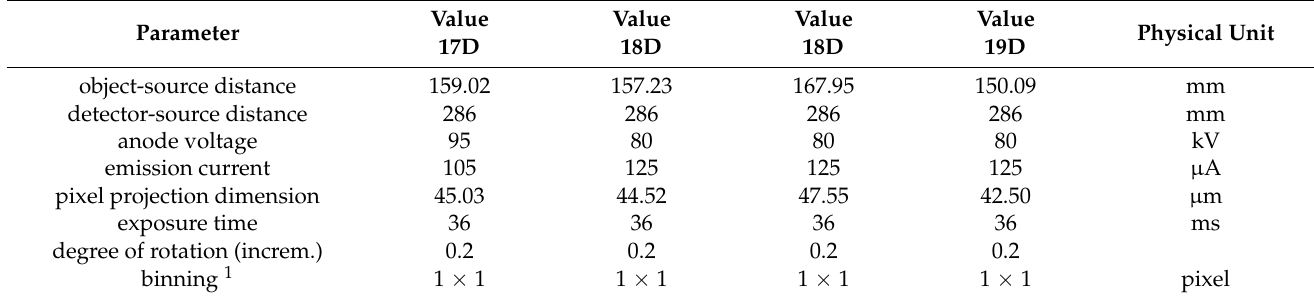
Table A10. Values of set parameters on SkyScan